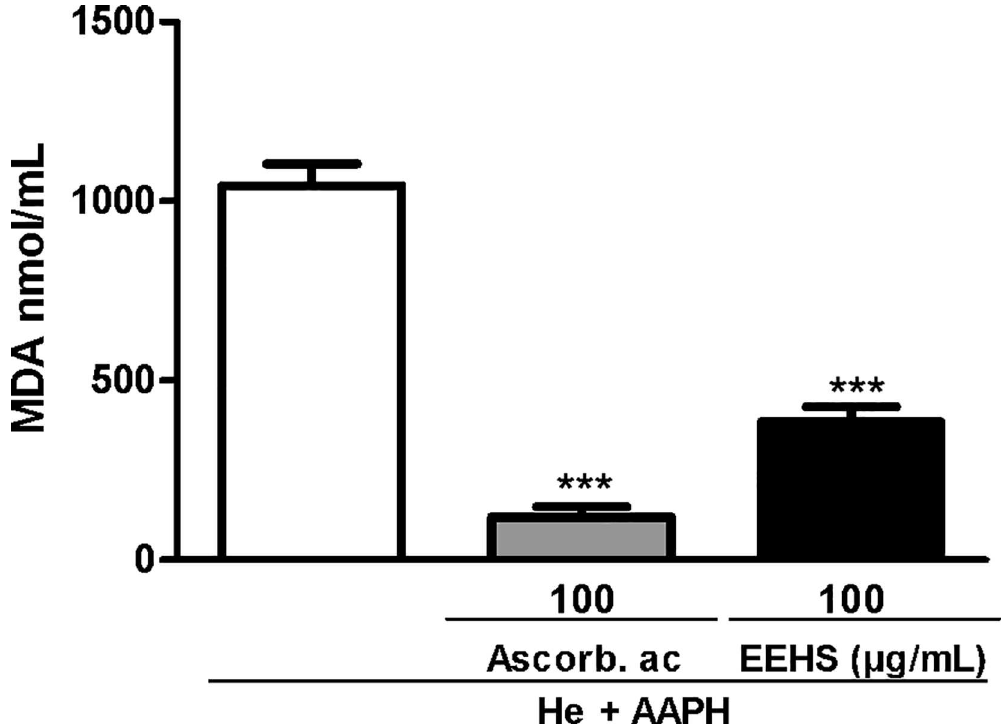
Fig 3. Effects of the EEHS on the inhibition of lipid peroxidation induced by AAPH. The control corresponds to erythrocytesincubatedwith AAPH alone.Values are expressedas the mean ± SEM of two independent experiments performed in duplicate. *** P < 0.001 when the treated groupswere comparedwith the AAPH group (erythrocytes incubatedwith AAPH alone).